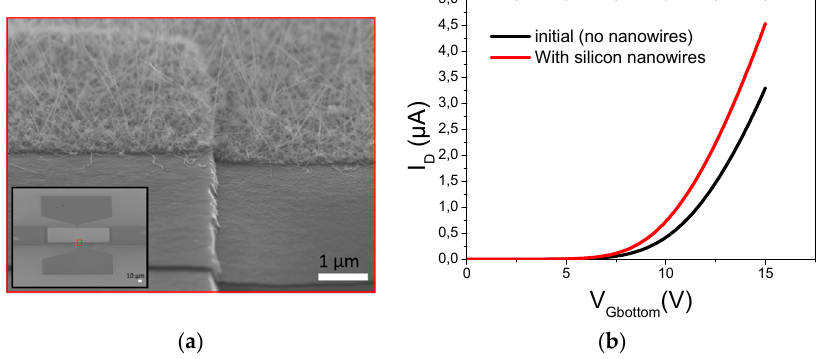
Figure 4. Integration of silicon nanowires on the active layer of the device: ( a ) SEM image showing the forest of silicon nanowires covering the active later and ( b ) I/V characteristics of the device before and after integration of the